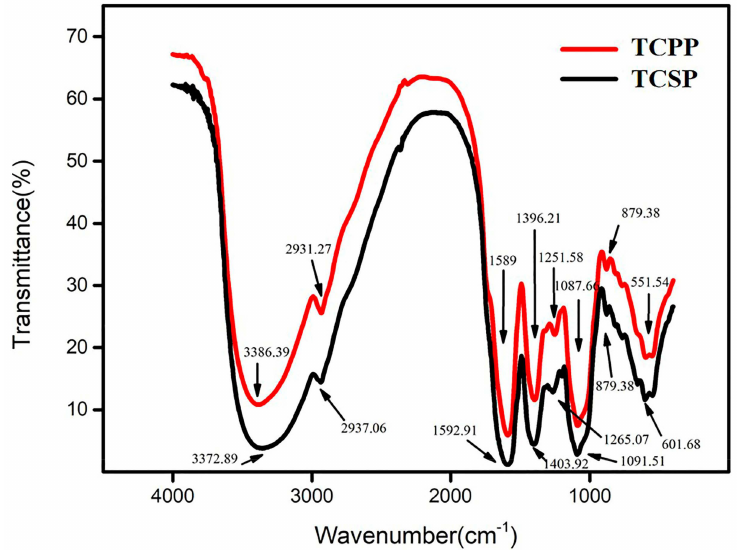
Figure 1. Fourier transform infrared spectrometry spectrum of TCSP and TCPP. TCSP: polysaccharides from stems of Trollius chinensis Bunge; TCPP: polysaccharides from petals of Trollius chinensis Bunge.